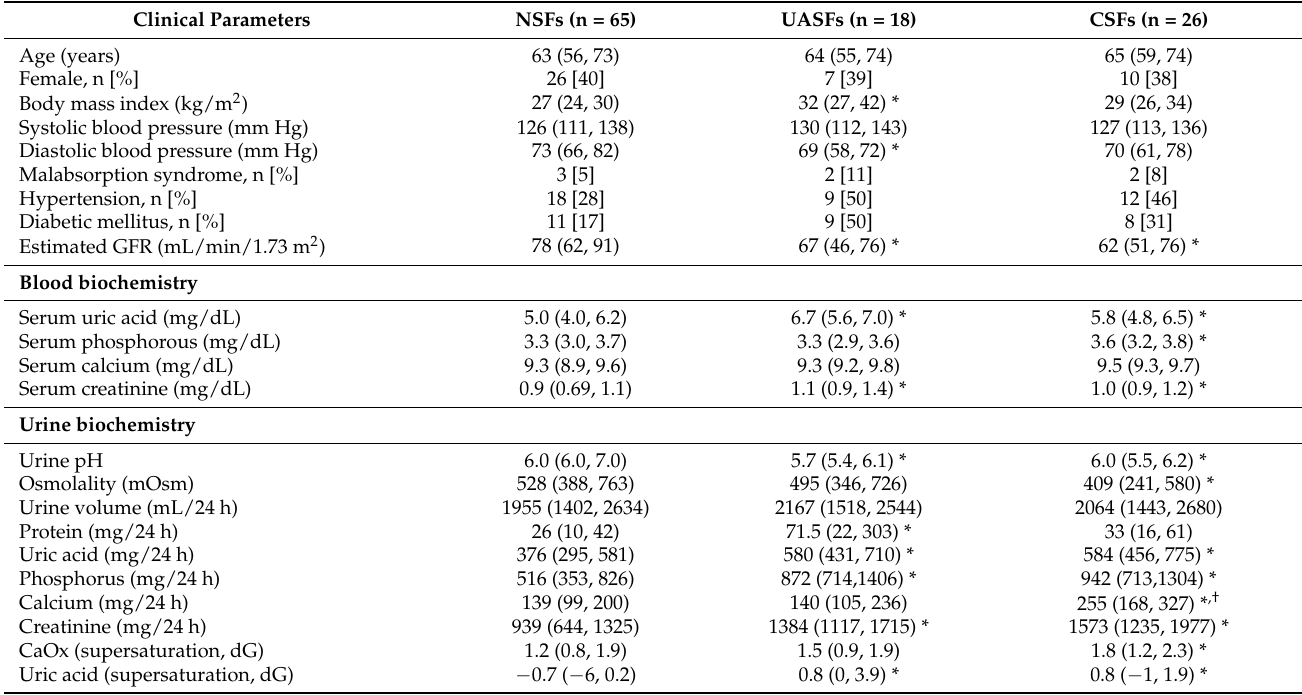
Table 1. Baseline clinical characteristics of study